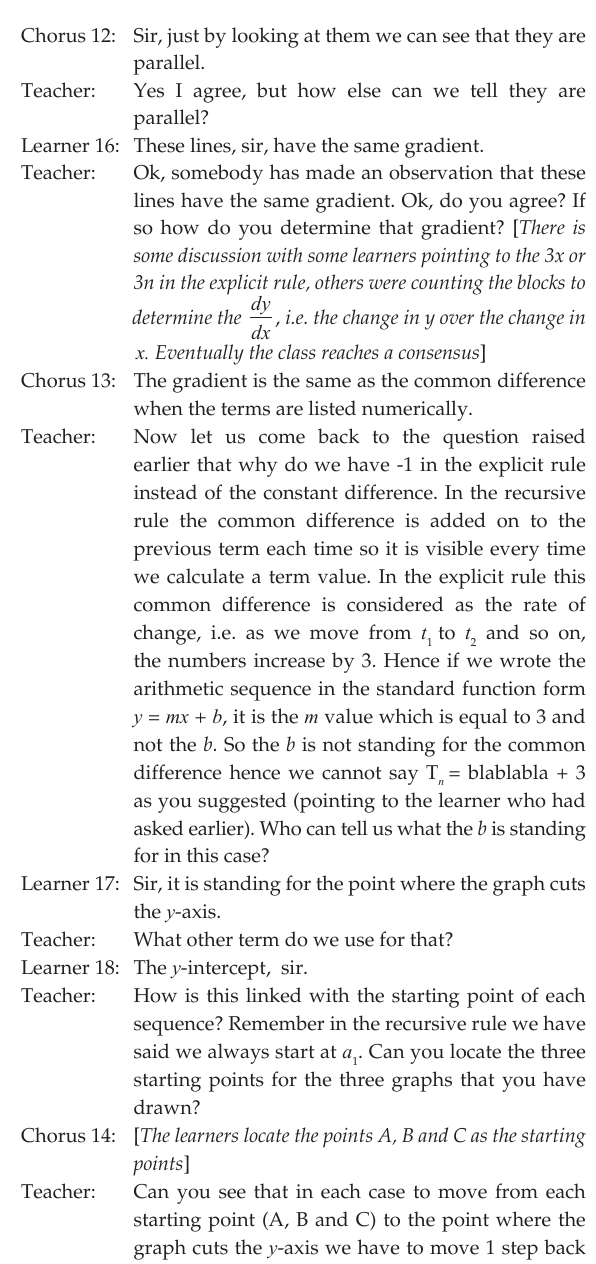
FIGURE 4: Graphs of the three arithmetic